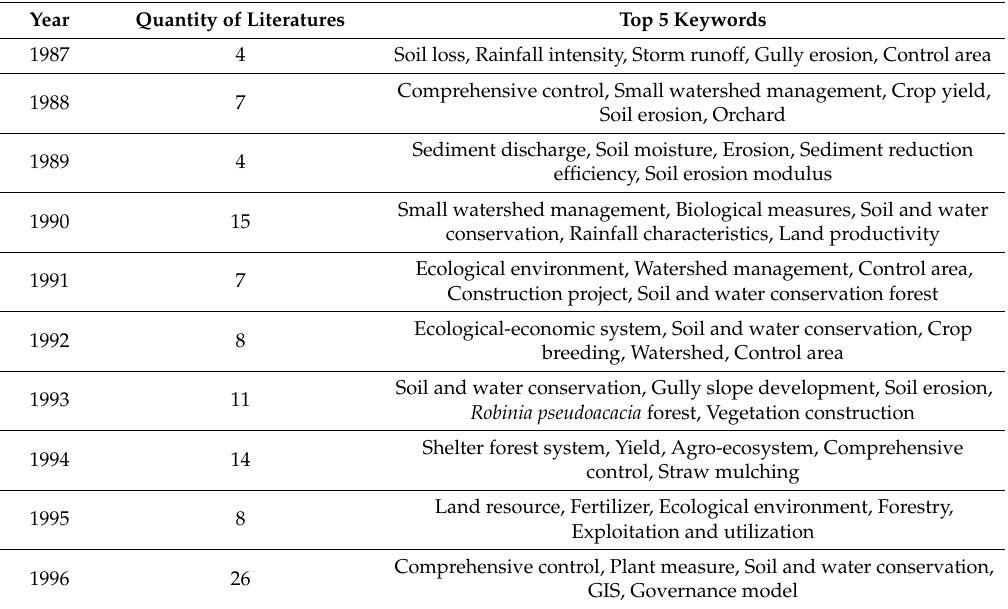
Table 1. Annual distribution of the main research topics of Chinese National Knowledge Infrastructure (CNKI) literature from